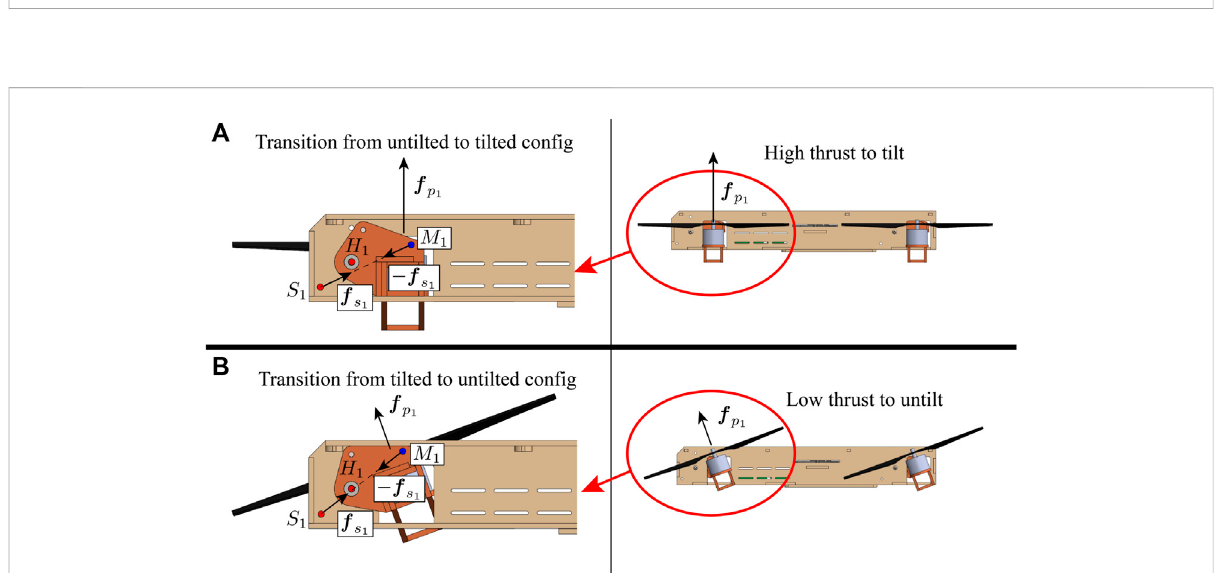
FIGURE 2 The vehicle viewing from the left side and the internal tilting mechanism for the front-right arm. (A) shows the vehicle in the untilted con fi guration, and (B) shows the vehicle in the tilted con fi guration. The fuselage is shown in beige. The arm shown in red orange is allowed to rotate around hinge H 1 . A spring isattachedbetweenpoint S 1 on the quadcopter central body and M 1 on the arm. The spring produces atorque on thearm around hinge H 1 that tries to keep the arm in the untilted con fi guration. The tensions in the spring are very close for the two con fi gurations becausetheamountofextensionisnearlyidentical.However,intheuntiltedcon fi guration (A) ,thedistancefromhinge H 1 toline S 1 M 1 islarge,leading toalargemomentarmandalargetorqueproducedbythespring.Thusthearmwillonlytiltwhenaveryhighthrustisproduced,allowingthevehicle intheuntiltedcon fi gurationtooperateatahighmaximumthrust.Oncethespringtorqueisovercomebyproducingahighthrust,thearmwilltiltand the vehicle will transition to the tilted con fi guration (B) . The torque exerted by the spring will reduce because the moment arm has reduced. This ensures that the arm will not untilt so easily, allowing the vehicle in the tilted con fi guration to operate at a low minimum